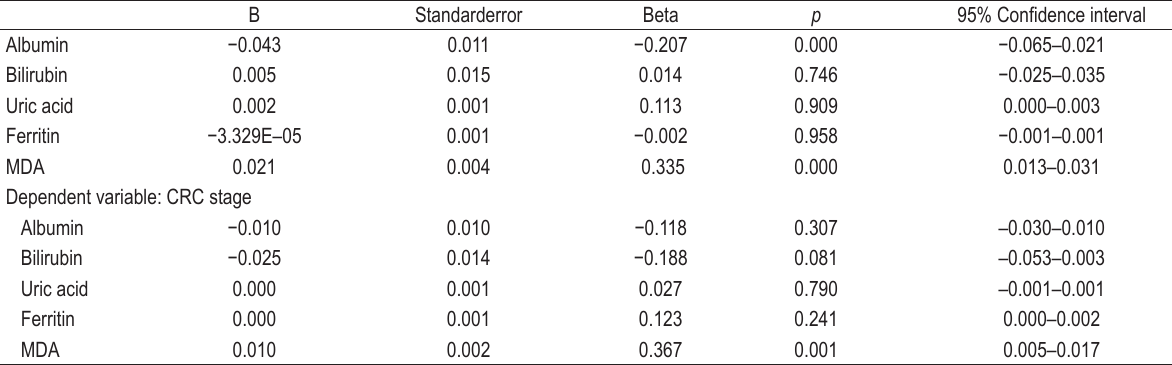
TABLE 4. Independent predictors of the CRC progression